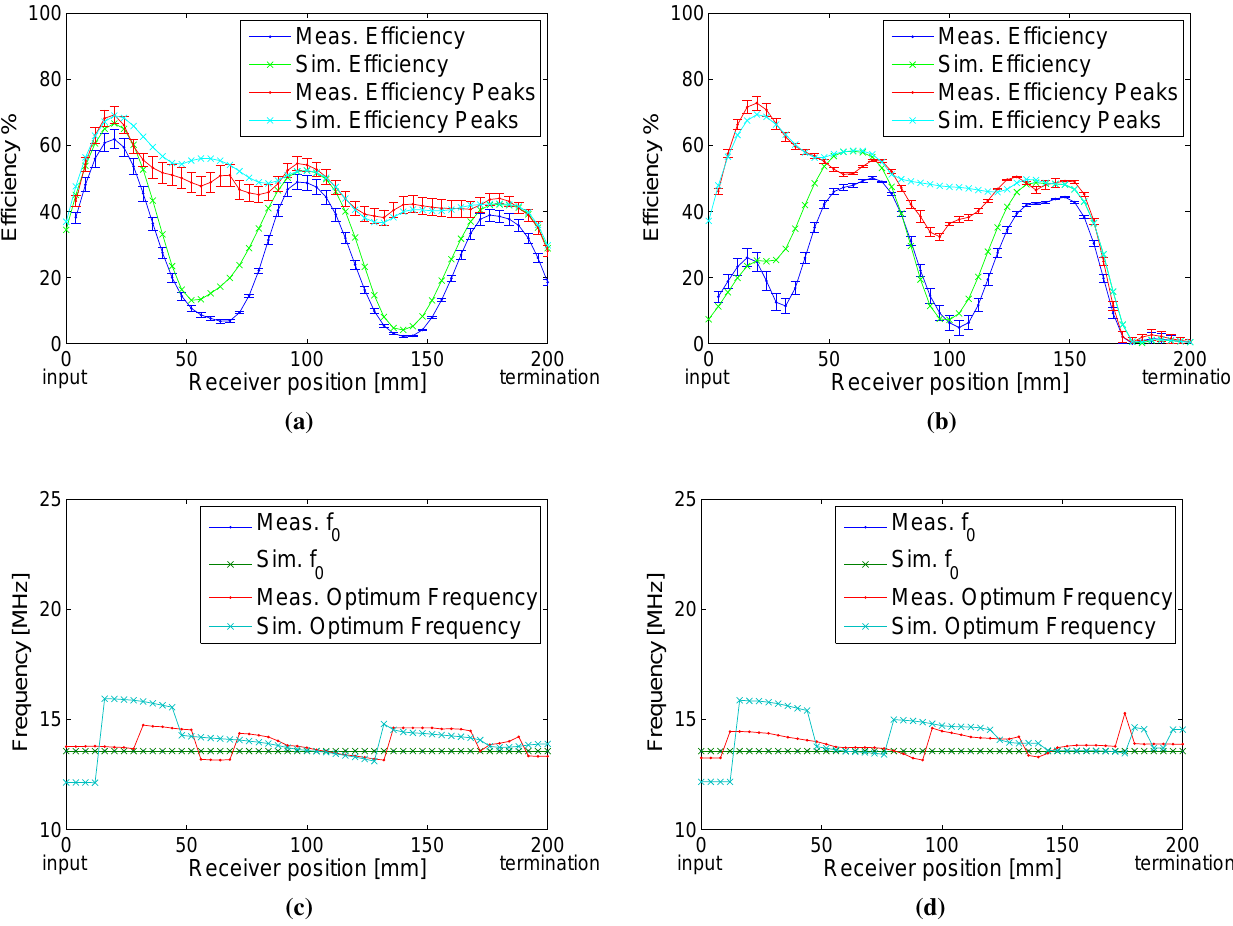
Figure 10. Comparison of measured and simulated efficiency and efficiency peaks and optimum frequency for Z T = 0 Ω ( a ) and ( c ) and Z T = 120 Ω , ( b ) and ( d ),